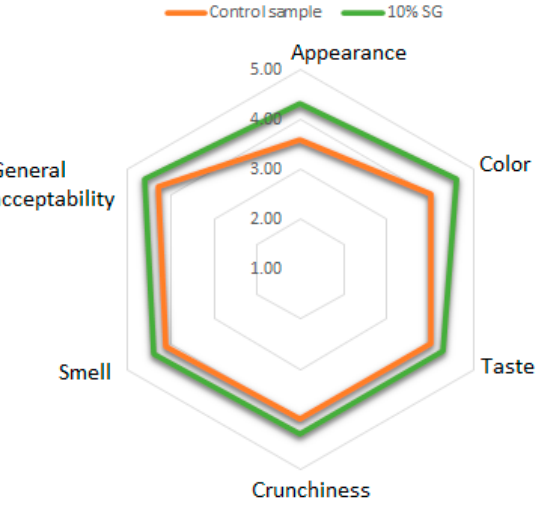
Figure 3. Sensory scores for spent grain wafers.